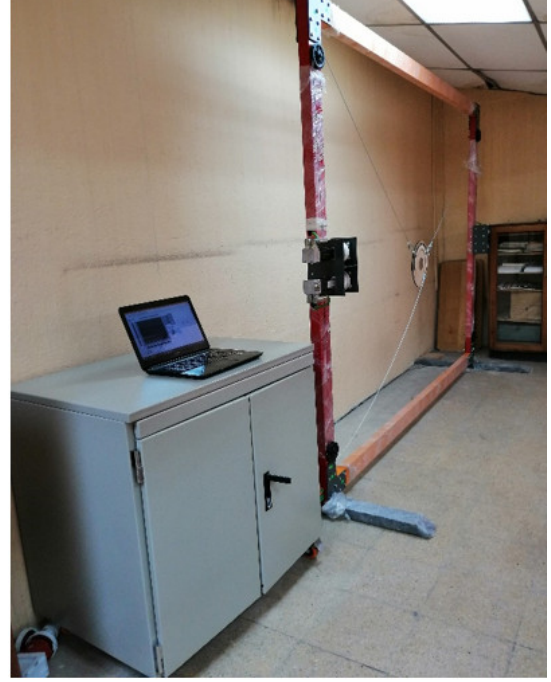
Figure 12. Planar CDPR assembled in the labs of Salesian Polytechnic University in Ecuador. Seven membership functions were considered for each input signal to the controller (error signal and derivative of the error), of which the intermediate five were triangular type and those at the ends were open-wing trapezoidal type, as shown in Figures 13 and 14. These membership functions were distributed evenly throughout the universe of discourse and named: large negative (NG), negative (N), small negative (NP), zero (Z), small positive (PP), positive (P), and large positive (PG).